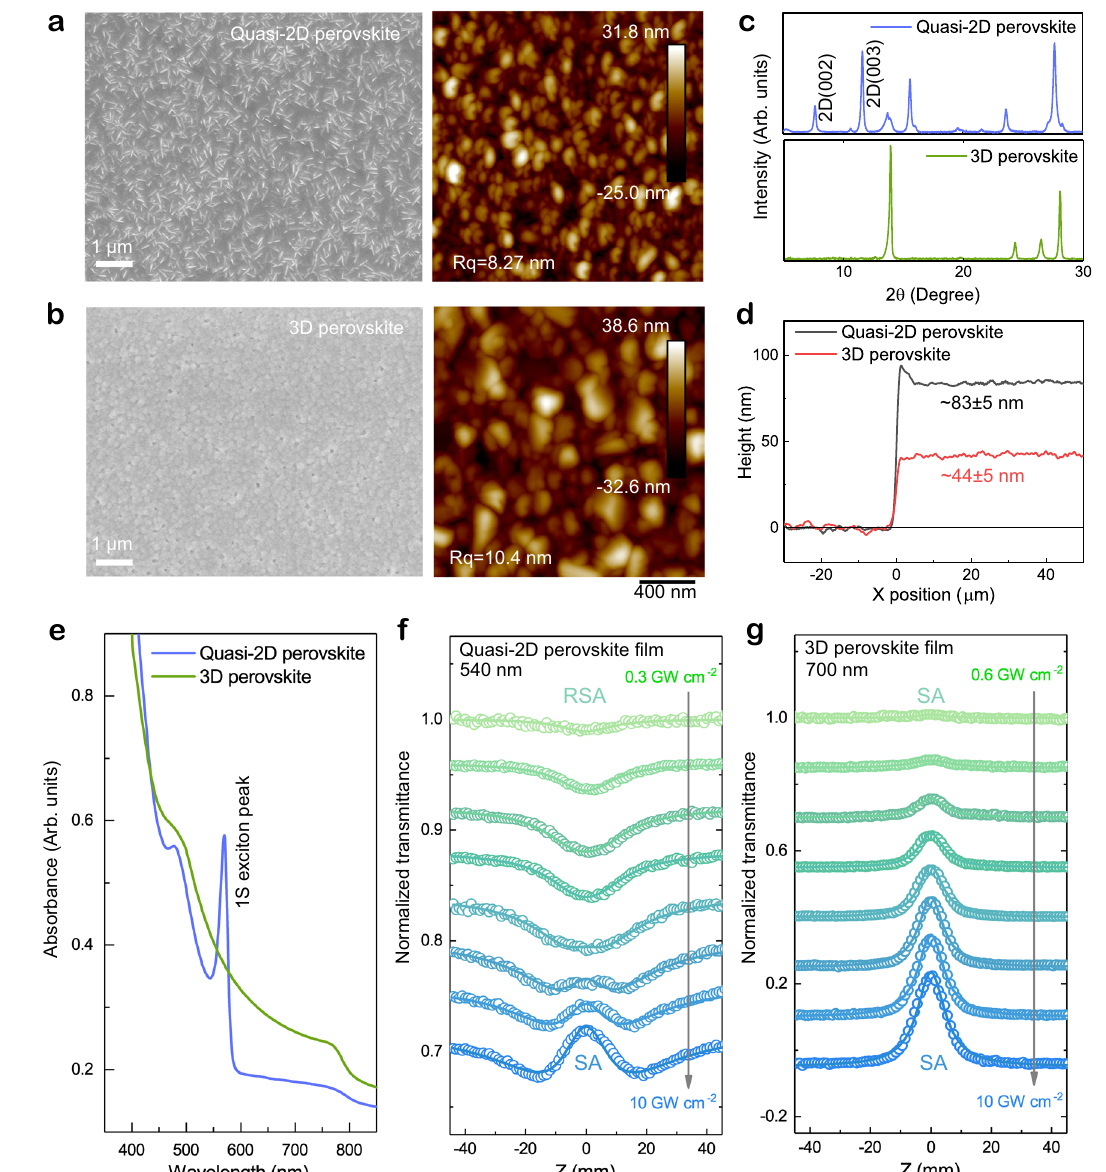
Fig. 2 | Physical properties and nonlinear optical characteristics. a , b Scanning electron microscope (SEM) and atomic force microscope (AFM) images of bilayer quasi-2D ( a ) and 3D ( b ) perovskite thin fi lms. c , d are the corresponding X-ray diffraction(XRD)patternsand fi lmsteppro fi les. e Linearultraviolet-visabsorbance (Abs.) spectra of the 3D perovskite and quasi-2D perovskite fi lm with a strong 1S exciton absorption peak at 570nm. f Z-scan pro fi le (hollow circles) evolutions of